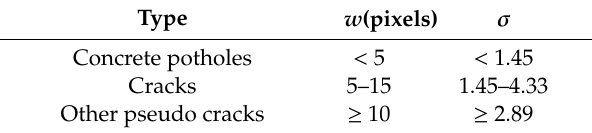
Table 1. Statistical table of crack and pseudo crack width.